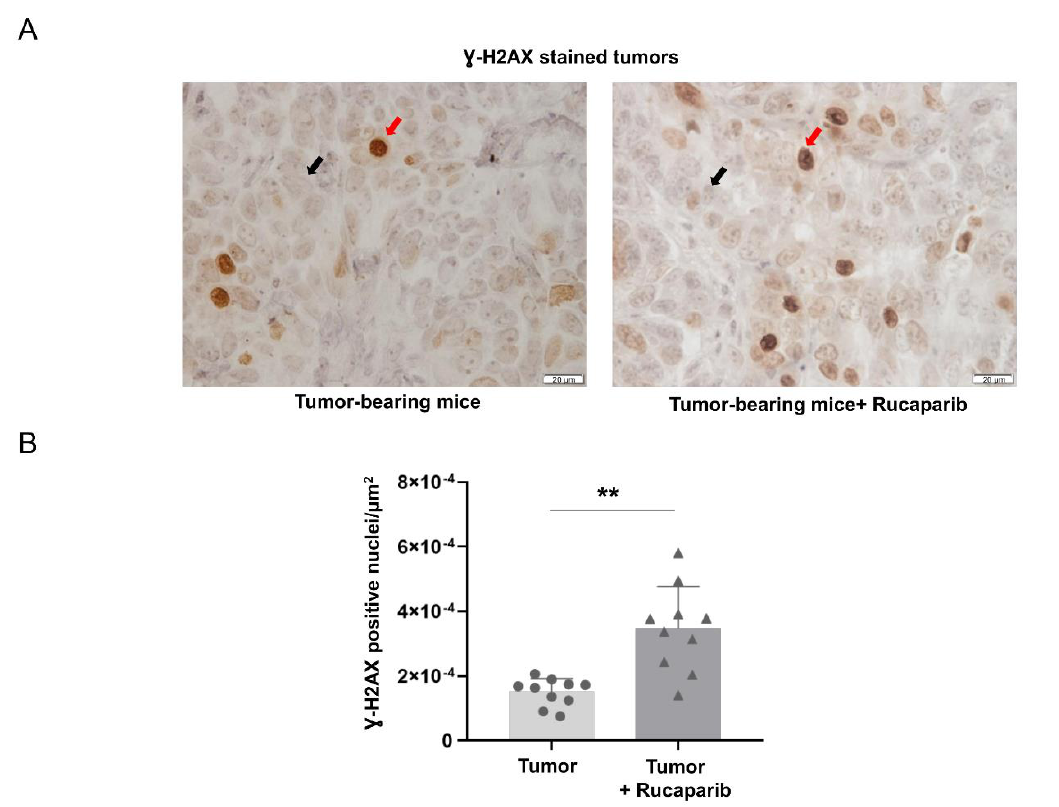
Figure 3. Representative examples of nuclei positively stained for Ɣ -H2AX (red arrows point towards brown nuclei) and not stained (black arrows point towards blue nuclei, hematoxylin counterstaining) in tumors of both experimental groups ( A ). Mean values and standard deviations of positively stained nuclei for Ɣ -H2AX in the total measured area ( B ). In the scatter plot, the circles represent the untreated tumor-bearing mice while the triangles represent the rucaparib treated tumor-bearing mice. Statistical significance: ** p ≤ 0.01 between tumor-bearing mice treated with rucaparib and non-treated tumor-bearing mice. Definition of abbreviations: Ɣ -H2AX, H2A histone family member X. Scale bar = 20 μ m, 40× magnification.